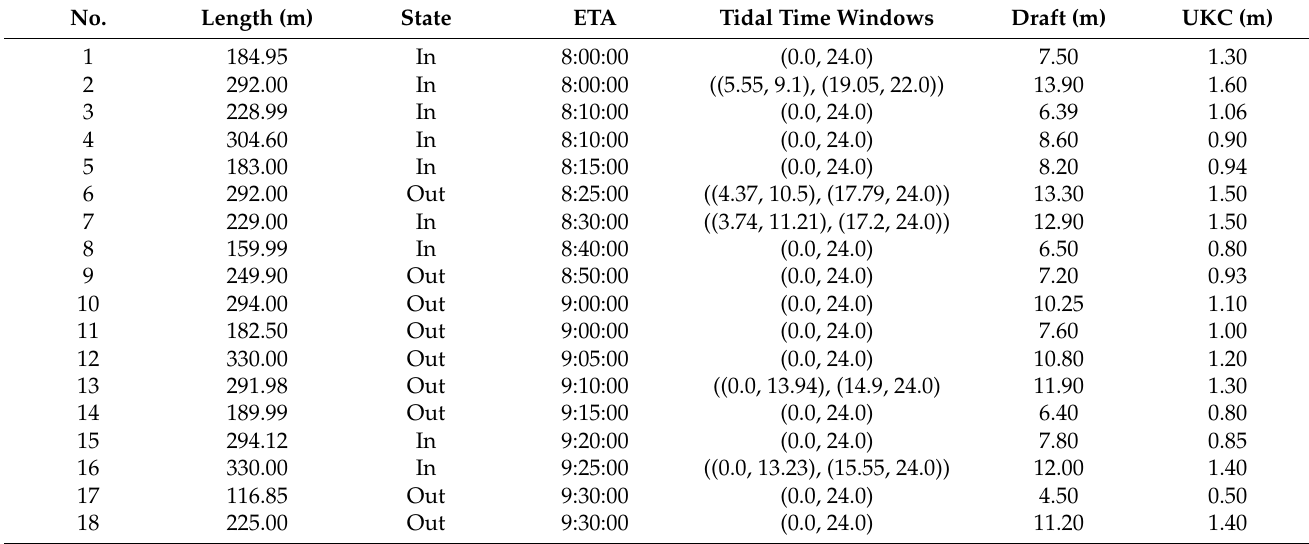
Table 7. Basic data of ship scheduling optimization.